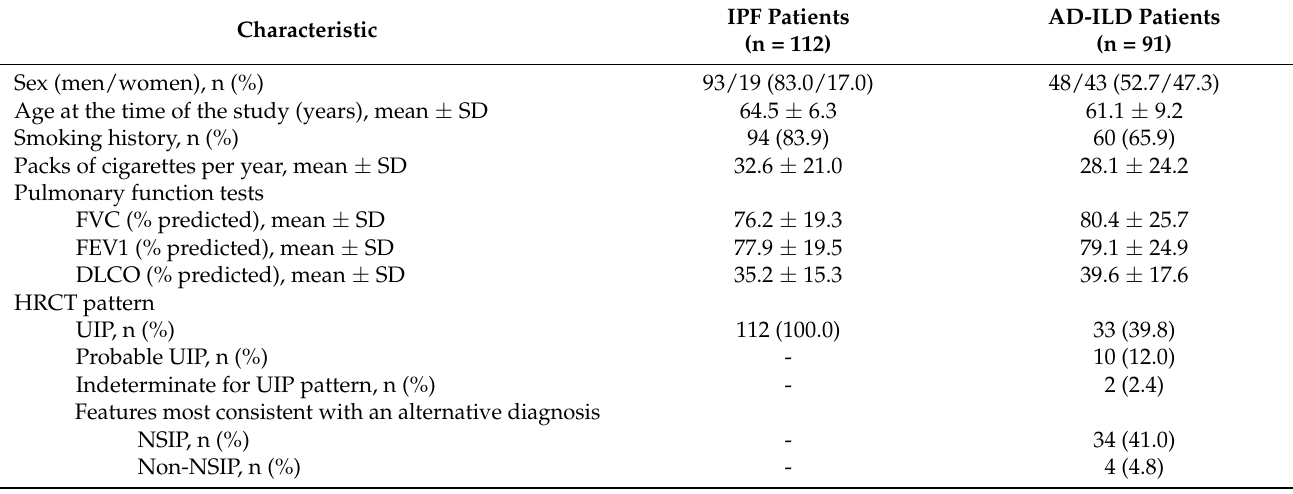
Table 2. Demographic and clinical characteristics of the patients included in the